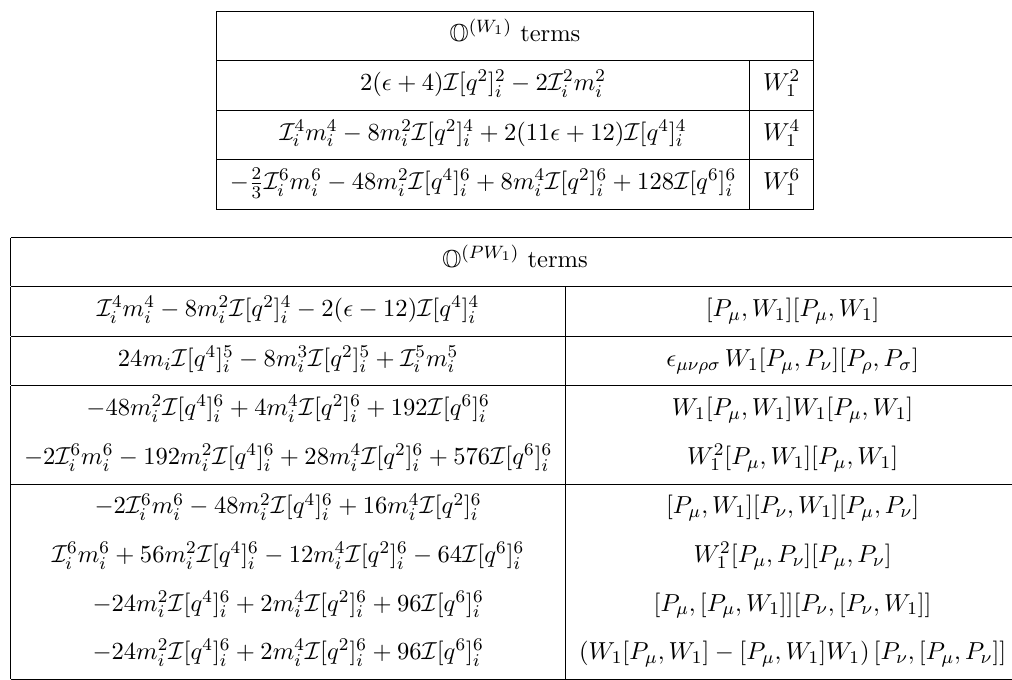
Table 6 . Operator structures in the degenerate fermionic UOLEA involving the pseudoscalar coupling W 1 .